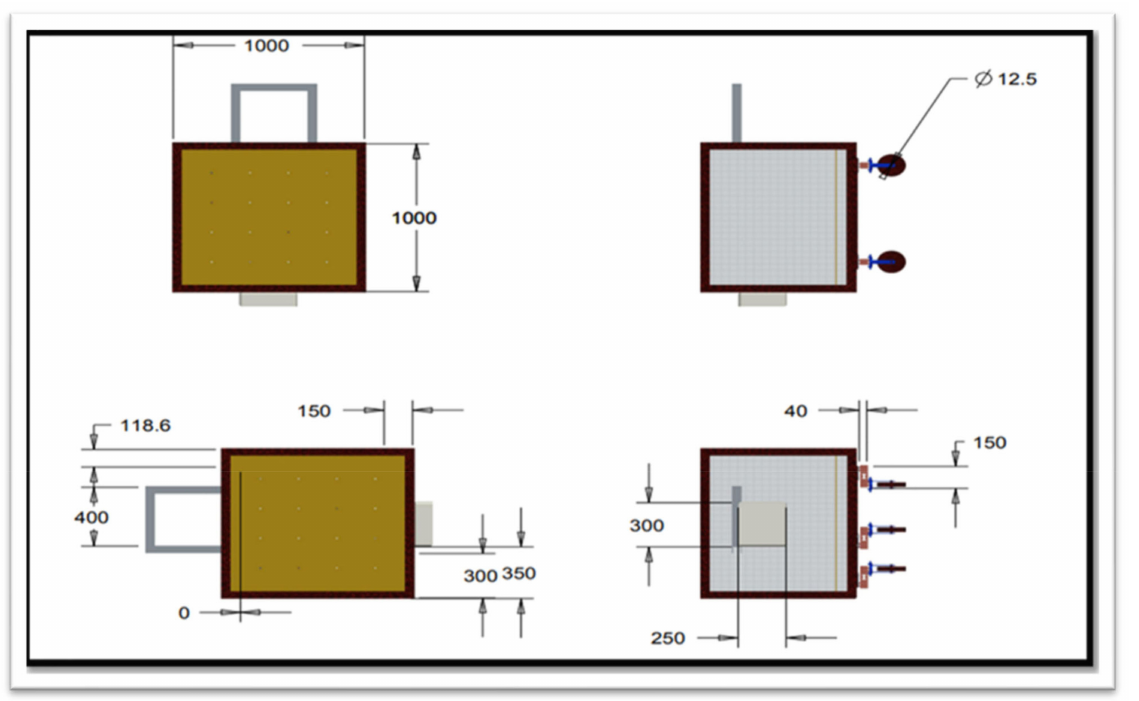
Figure 4. Dimensions of the various lysimeter components, selected for a chrysanthemum plantation, were 1000 mm × 1000 mm × 600